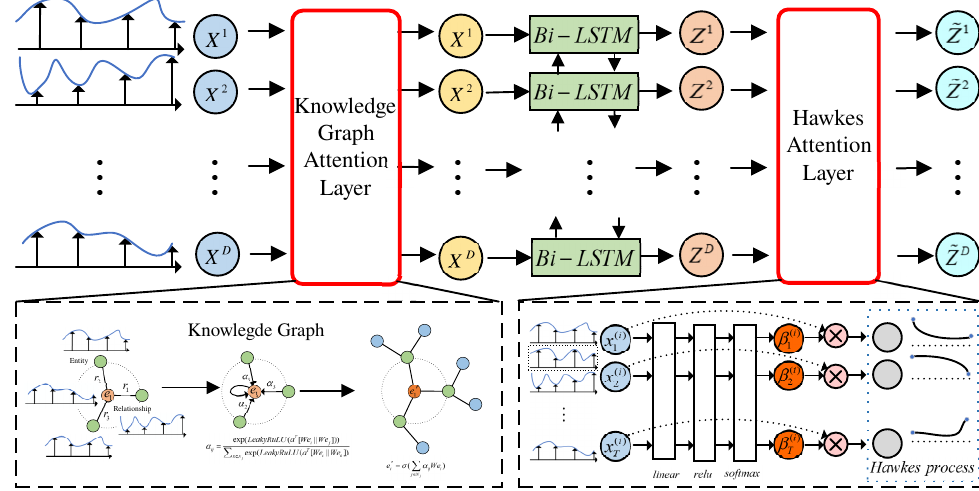
Figure 4. The structure KH-LSTM with knowledge graph attention and Hawkes